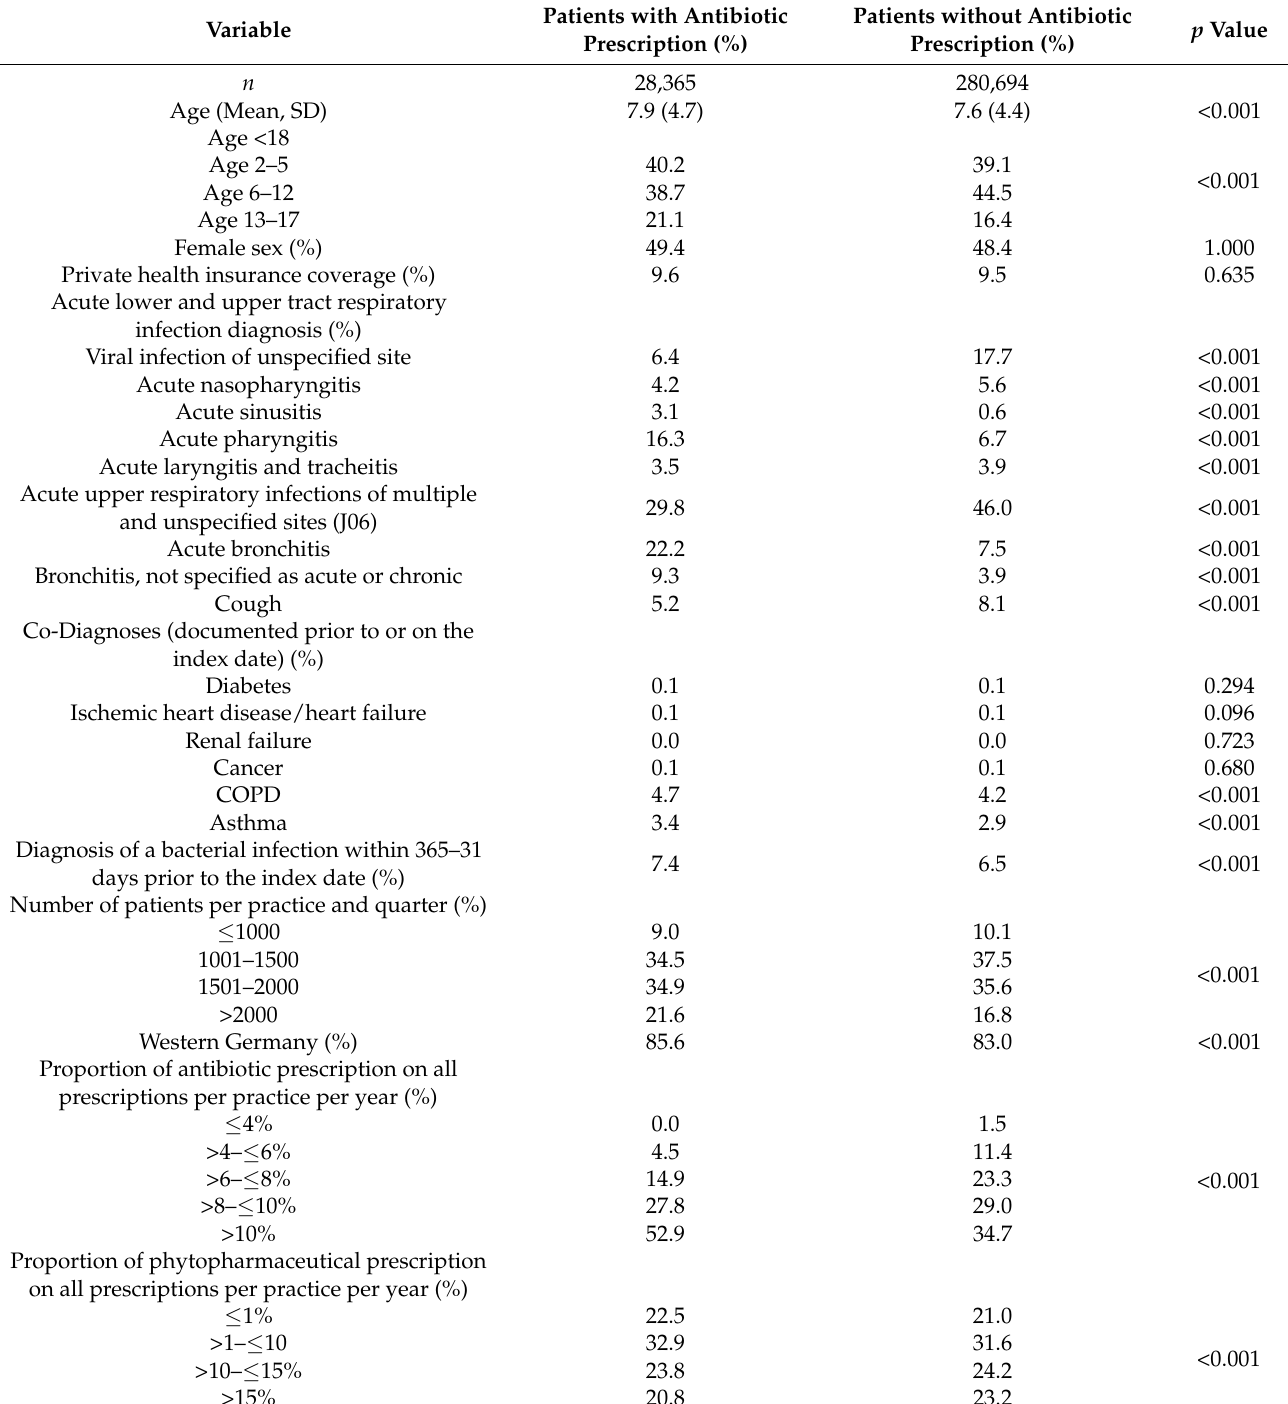
Table 2. Baseline characteristics of study patients in pediatric